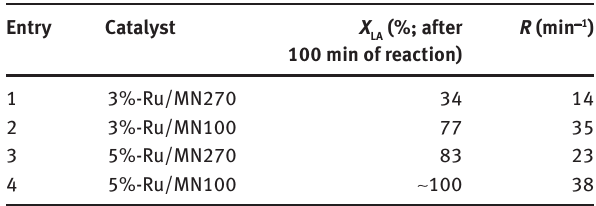
Table 2: Results of catalytic testing of Ru/hypercrosslinked